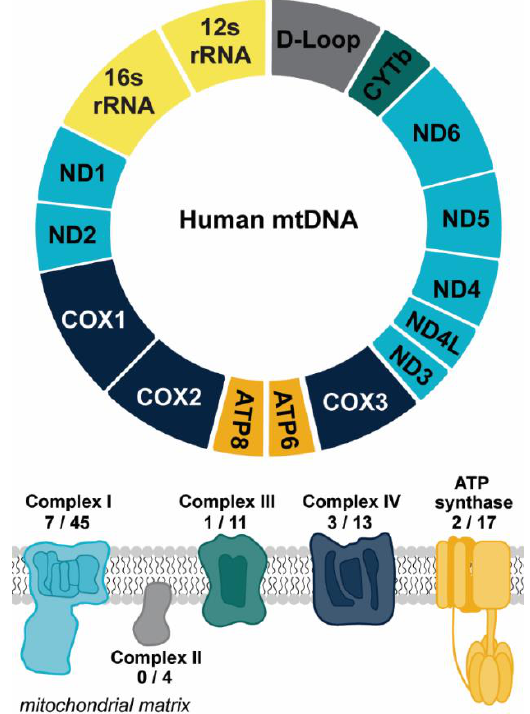
Figure 1. Overview of mtDNA. Mitochondrial DNA encodes for 13 protein subunits involved in oxidative phosphorylation (OXPHOS), the main energy-producing pathway of the cell. The diagram depicts the protein coding genes found within the mitochondrial genome that encode for subunits of OXPHOS complexes. Genes are color coded to correspond to the color of the OXPHOS complex. The numbers reflect the number of protein subunits of each complex encoded by the mitochondria out of the total number of protein subunits. The genetic instructions for the remaining subunits are carried in the nucleus. The 22 transfer RNAs encoded by the mitochondrial genome are not shown.